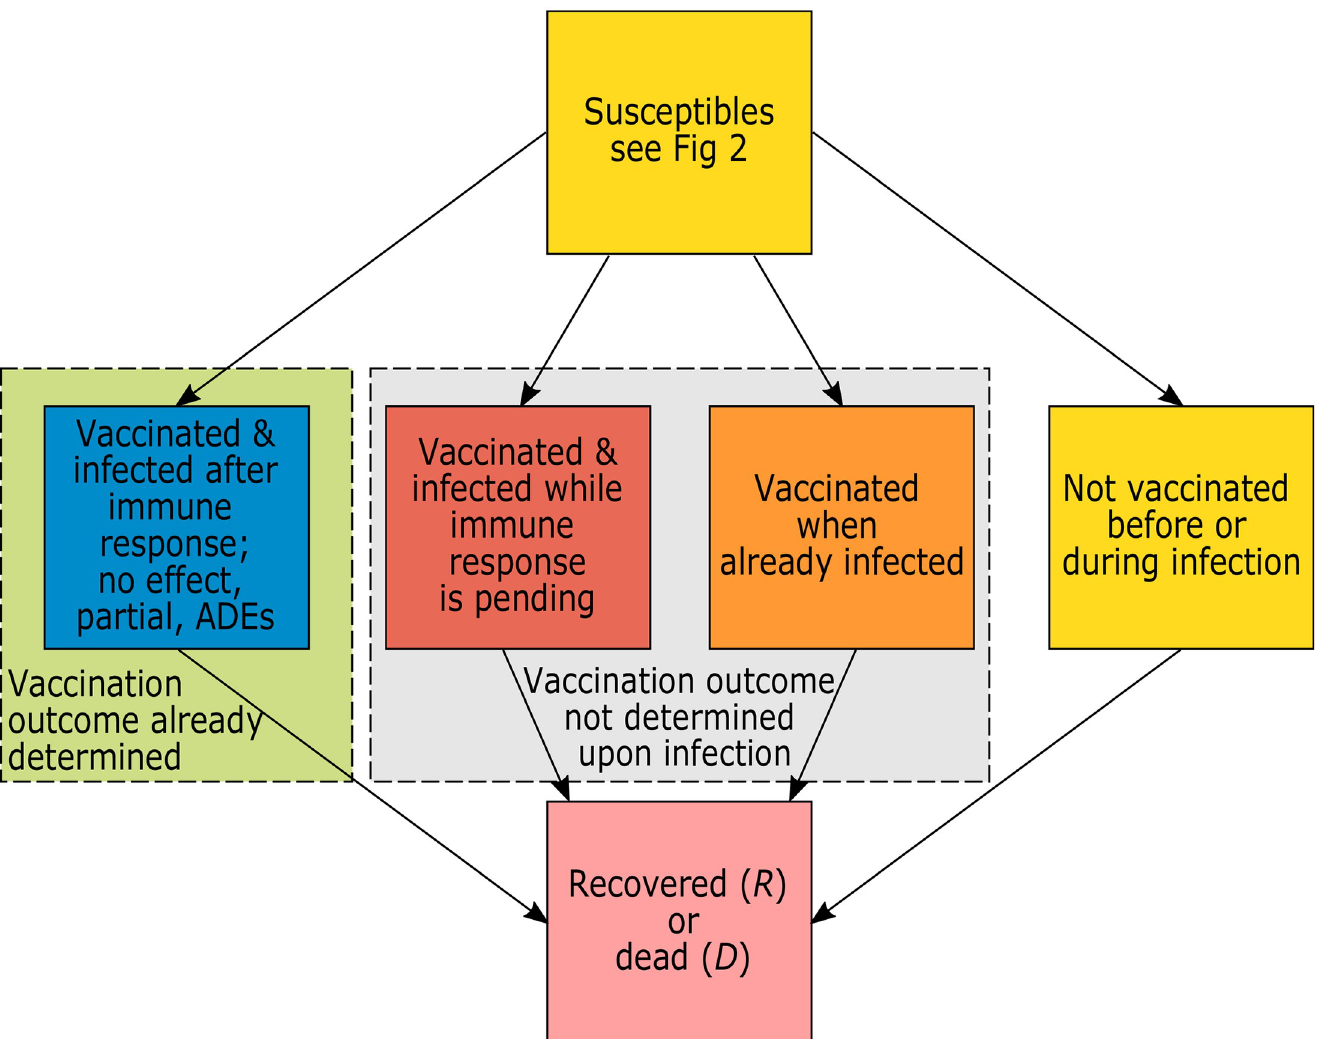
Fig 3. Simplified model flow. Susceptible individuals are infected and ultimately recover or die. Individuals are infected either after or before the outcome of the vaccination is determined. In the latter case the outcome of the vaccine is not determined upon infection (they might get vaccinated before or during the infection), or they are not vaccinated before or during the infection (this includes unvaccinable individuals that get